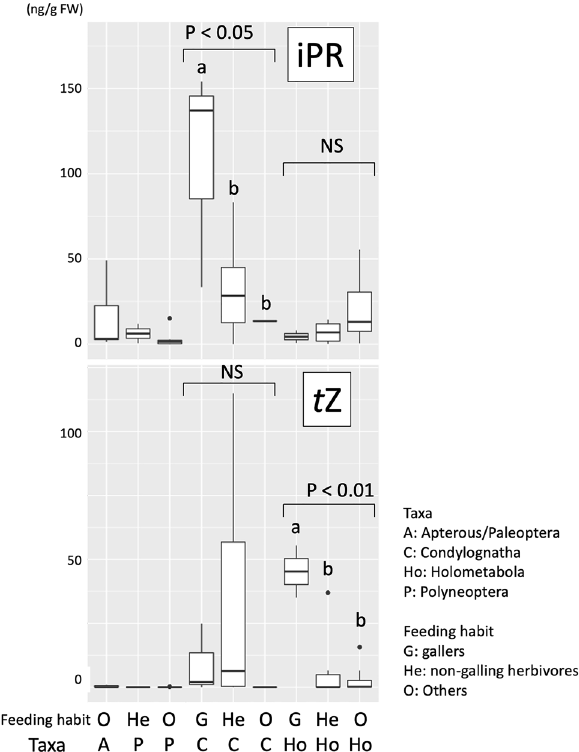
Figure 4. Comparison of endogenous concentrations of trans -zeatin ( t Z), and isopentenyladenosine (iPR) among different feeding habits of insects. Because significant interaction effects between taxa and feeding habit were detected, concentrations were compared among different feeding guilds within Condylognatha and Holometabola,